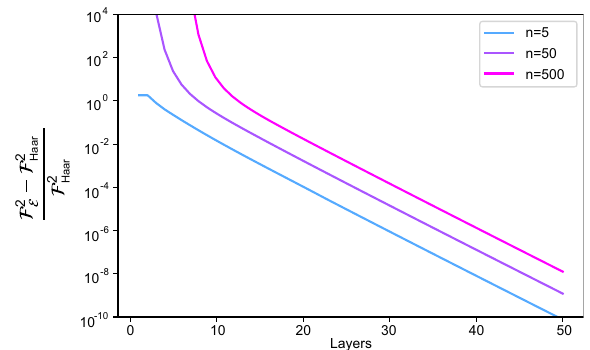
Fig. 1 Theoretical fractional deviation of the k = 2 frame potential from the Haar value as a function of layers for the parallel random unitary ansätz. In this plot, the layer required to reach a fi xed F does not scale linearly with n . The linear scaling is only for fi xed ϵ